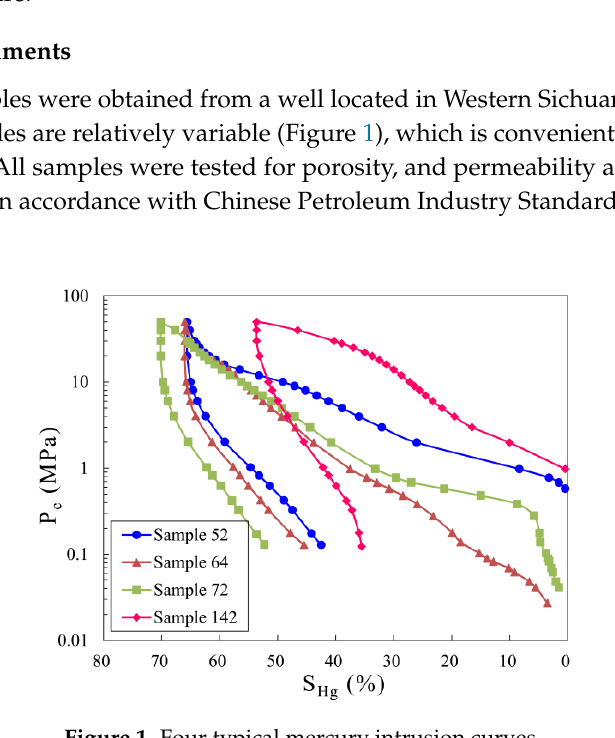
Figure 2. Pore size distributions of four samples obtained using mercury analysis. 4. Results and Discussion 4.1. Single Fractal Characteristics Equation (1) was applied to obtain the fractal dimensions of the 13 mercury injection data. The results (Table 2) show that the high R-squared value demonstrates that fractal method is useful for mercury intrusion porosimetry (Figure 3). The fractal curves exhibit a two-stage characteristic and the corresponding fractal dimensions D 1 and D 2 can characterize the complexity of pore structure in different sizes. Despite the different pore size distributions, all 13 mercury intrusion curves exhibit a two-stage fractal characteristic. D 1 of 13 samples varies widely, while D 2 is mainly distributed around a value of 3.2.